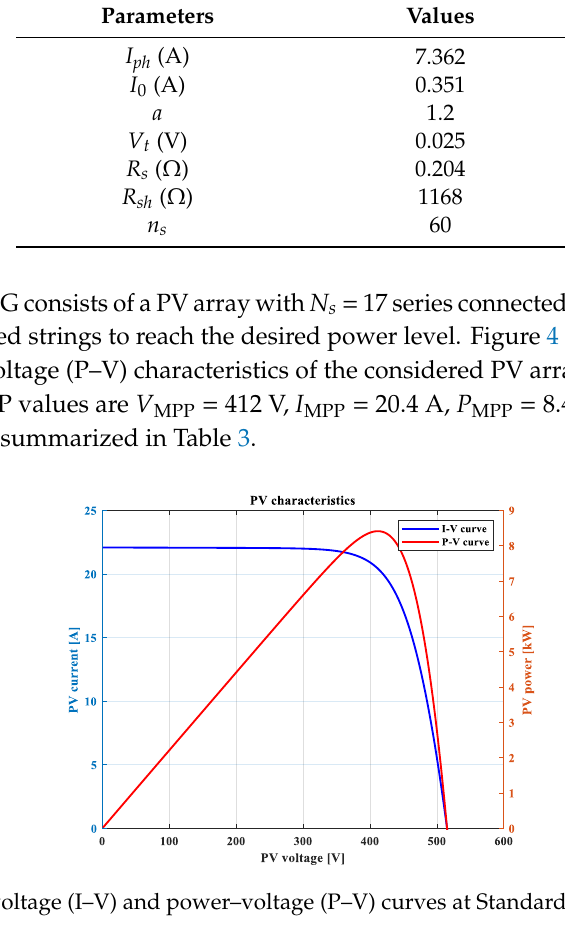
Table 3. Control parameters.